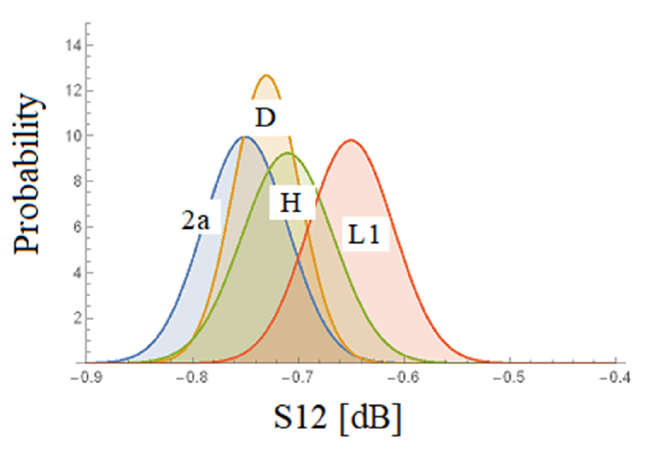
Figure 12. Master diamonds S12 magnitude in a bell-shaped graph at a frequency of 17.72 GHz.